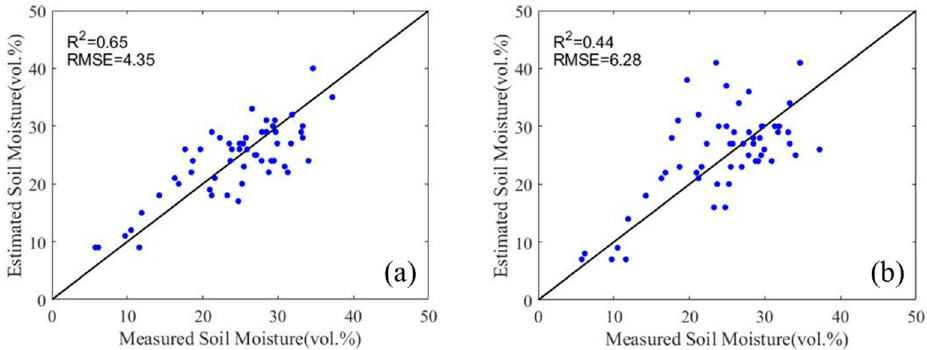
Figure 7. ( a ) Scatterplots between the measured and predicted SMC values on the validation set based on LAI (Ratio method); ( b ) scatterplots between the measured and predicted SMC values on the validation set based on RVI, the same date as LAI (Ratio method).